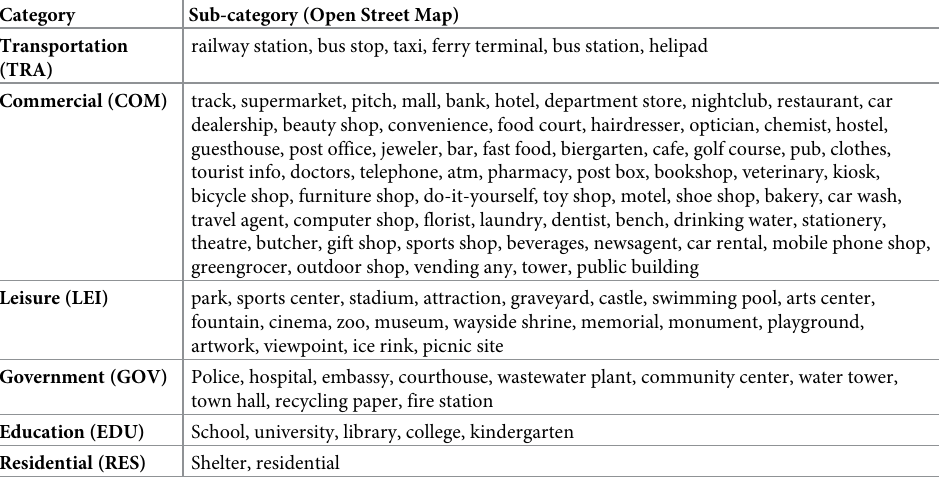
Table 1. Categories of